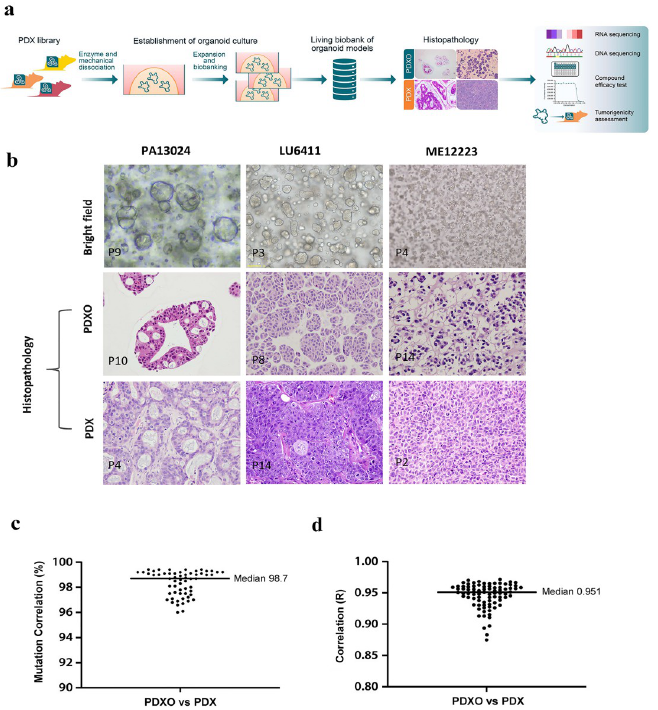
Fig 1. Establishment and characterization of a PDXO biobank. a) Schematic workflow of the establishment of PDXOs from PDX library of Western and Asian patient origins and characterization of banked models. b) Bright field (top panel) and H&E staining (histopathology, middle panel) of three selected PDXO models (pancreatic tumor, lung tumor and melanoma), showing cystic, compact and grape-like phenotypes, and H&E staining of matching PDX (bottom panel); c) WES analysis of 59 matched PDX/PDXO data sets from 9 different cancer types (colon, lung, gastric, pancreatic, ovarian, breast, cholangiocarcinoma, liver and bladder) and d) RNAseq expression analysis from 83 matched PDX/PDXO data sets across 11 cancer types (colon, lung, gastric, pancreatic, ovarian, breast, cholangiocarcinoma, liver, bladder, esophageal and melanoma) with median values shown.